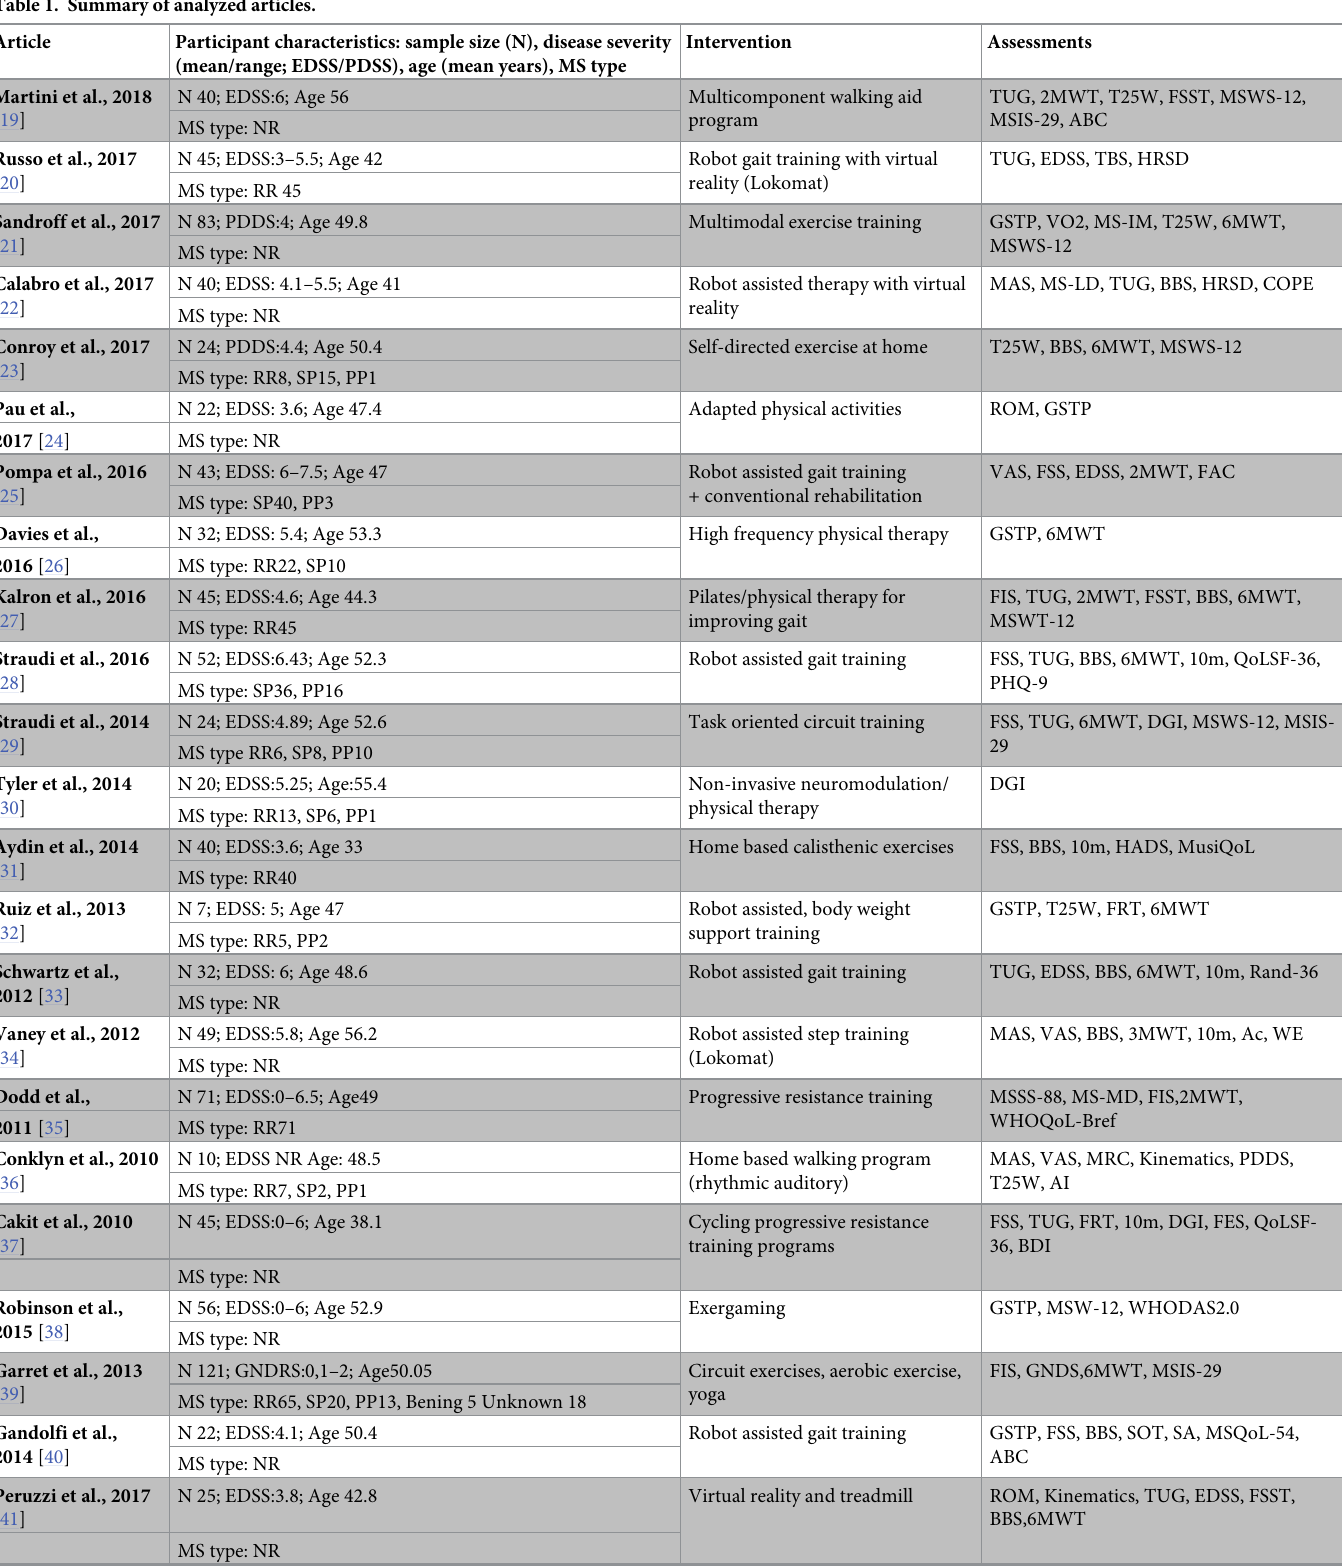
Table 1. Summary of analyzed